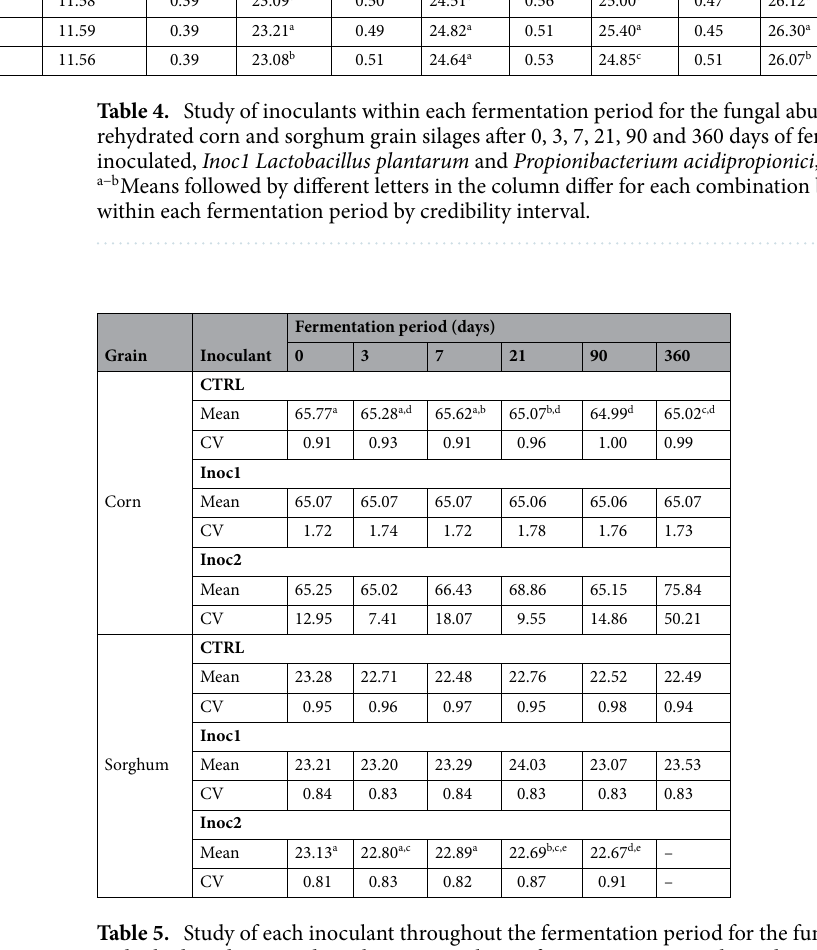
Table 5. Study of each inoculant throughout the fermentation period for the fungal abundance of ground and rehydrated corn and sorghum grain silages after 0, 3, 7, 21, 90 and 360 days. CTRL non-inoculated, Inoc1 Lactobacillus plantarum and Propionibacterium acidipropionici , Inoc2 Lactobacillus buchneri. a−e Means followed by different letters in the line differ by credibility